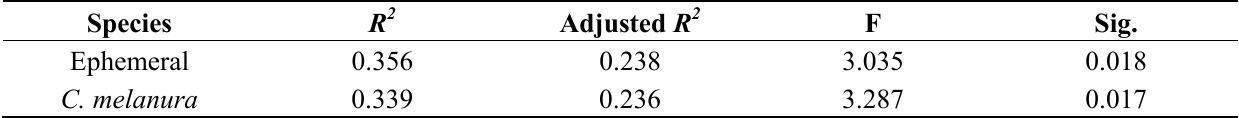
Table 2. Summary of the HSI linear regression models.